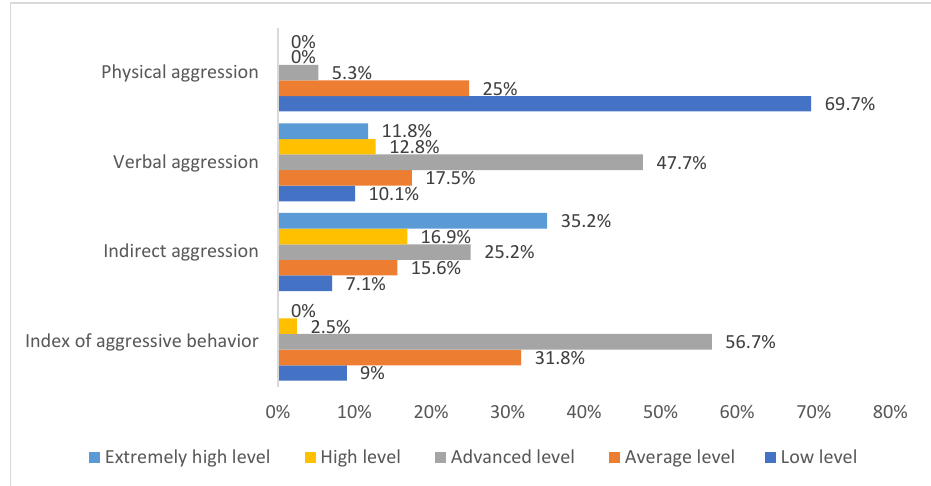
Figure 4. The frequency distribution of HCWs of COVID-19 ICUs by levels of aggression and its components.